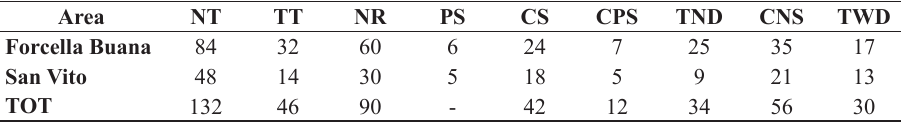
Table 7. Accuracy measurement for larvae of flower chafers species. NT: total number of trees; TT: total number of targets. Indication by Teseo: NR: no reaction, PS: partial signalling, CS: complete signalling; Results: CPS: correct positive signalling, TND targets non-detected, CNS: correct negative signalling, TWD: target wrongly detected.